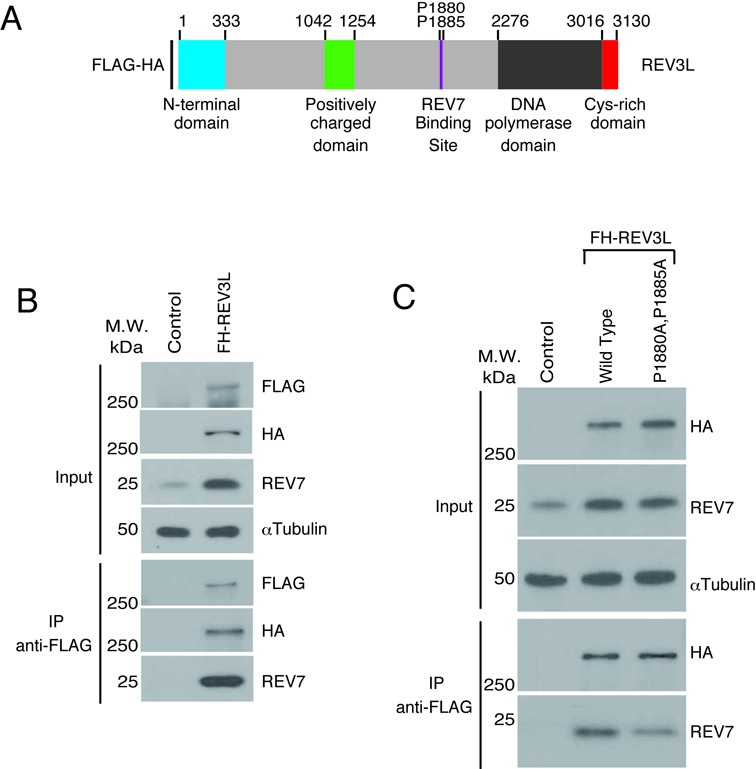
REV7 interacts with full-length REV3L in vivo. (A) Schematic of REV3L, showing the locations of the evolutionarily conserved N-terminal domain, the B-family DNA polymerase domain and the previously proposed REV7 binding site. An iron-sulfur cluster in the Cys-rich domain near the C-terminus provides a binding site for the POLD2 subunit. The position of FLAG and HA tags is shown. (B) Human 293T cells were transfected with either epitope-tagged REV3L (FH-REV3L) or Flag-HA empty vector (Control). Forty-eight hours after transfection cell lysates were made and used for immunoprecipitation with FLAG antibody beads. After electrophoretic transfer of proteins, the membrane was cut into three sections to separate proteins >250 kDa (FLAG), 37 to 250 kDa (HA and α-tubulin) and <37 kDa (REV7) and immunoblotted with the indicated antibodies. Results for the input and IP product after gel electrophoresis are shown. (C) FLAG-IP experiment similar to part A, using FH-REV3L, FH-REV3L mutant construct (P1880A, P1885A) and control empty vector.